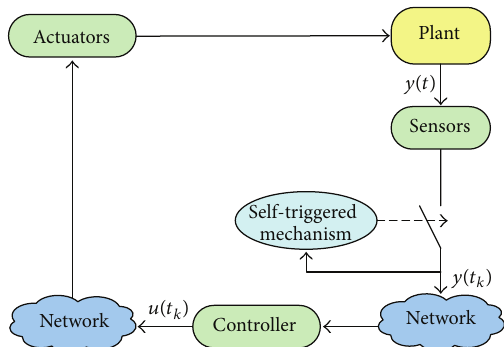
Figure 3: General configuration of NCSs with self-triggered sam-